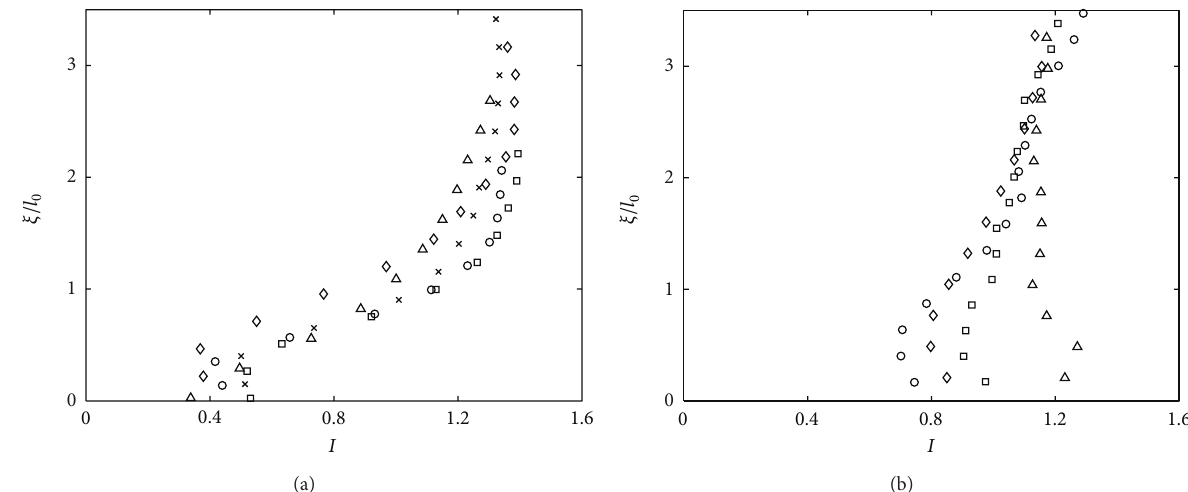
Figure 7: Plots showing measurements of isotropy for (a) 𝑅𝑒 𝑙 ≥ 117 and (b) 𝑅𝑒 𝑙 < 117 against dimensionless distance above the tank base 𝜉/𝑙 0 . Refer to Figures 3 and 6 for legends of plots in (a) and (b), respectively.